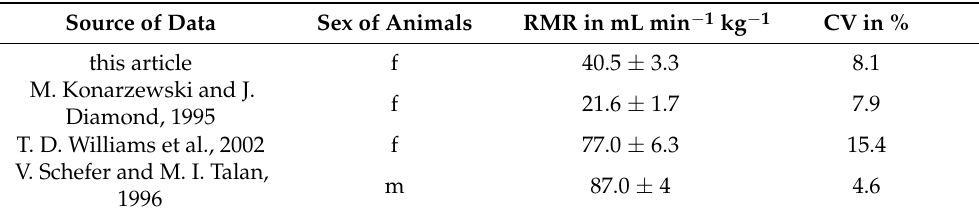
Table 1. Overview of the measured resting metabolic rate (RMR) with the associated coefficient of variability (CV) and the comparison to the literature